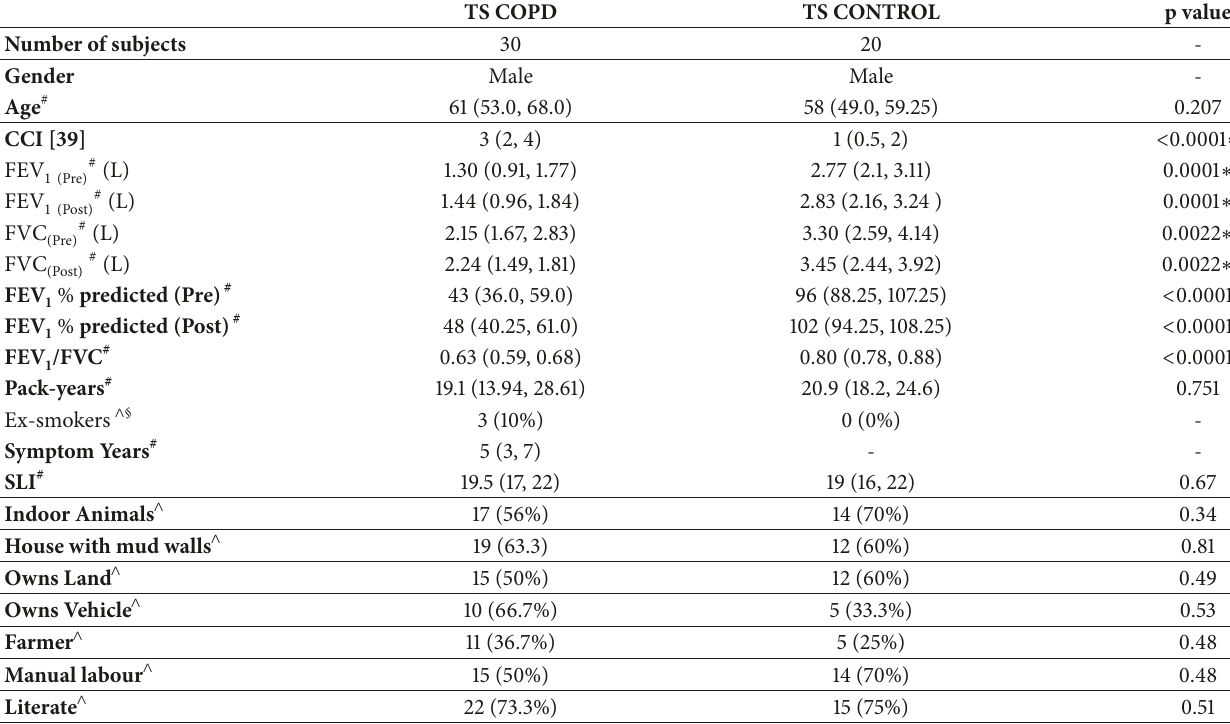
Table1:Demographicsofthestudycohortconstitutingtobaccosmokerswithchronicobstructivepulmonarydisease(TSCOPD)andtobacco smokers without COPD (TS CONTROL). Values are presented as # median (25th–75th percentile) and ∧ frequency (percentage). § Only